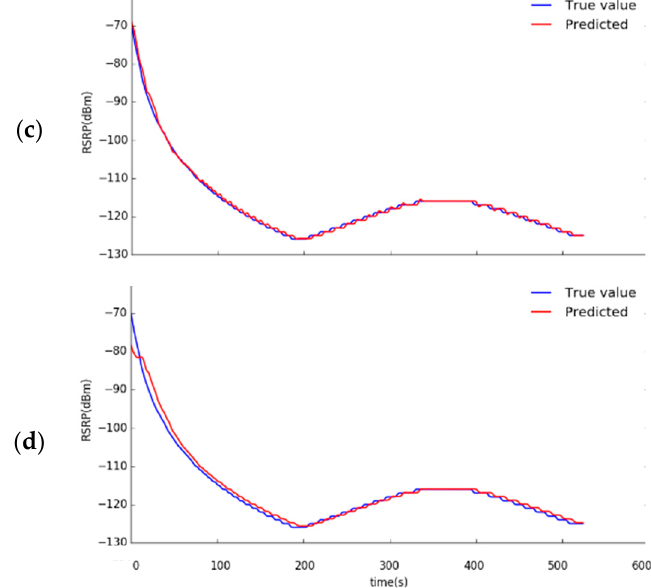
Figure 16. Predicted RSRP results for the next 4 s: ( a ) MLP, ( b ) CNN, ( c ) RNN, ( d ) LSTM.